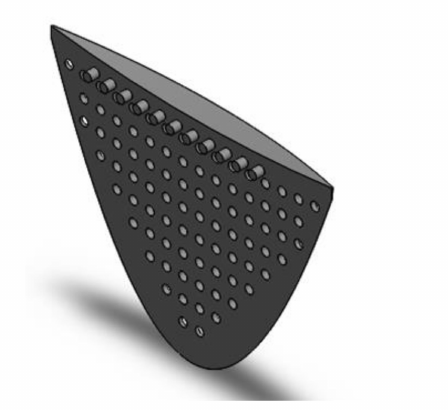
Figure 2. Arch support seen from the bottom in a raised